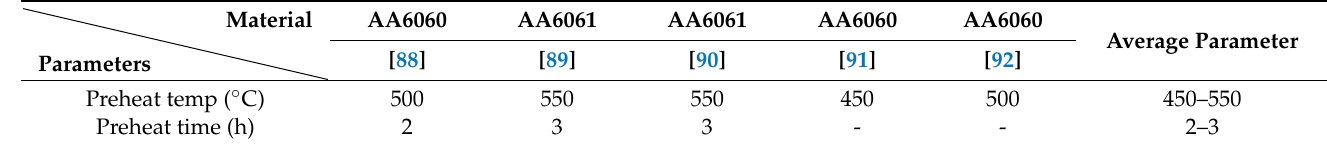
Table 9. Extrusion time and temperature for various Al alloy-based composites.